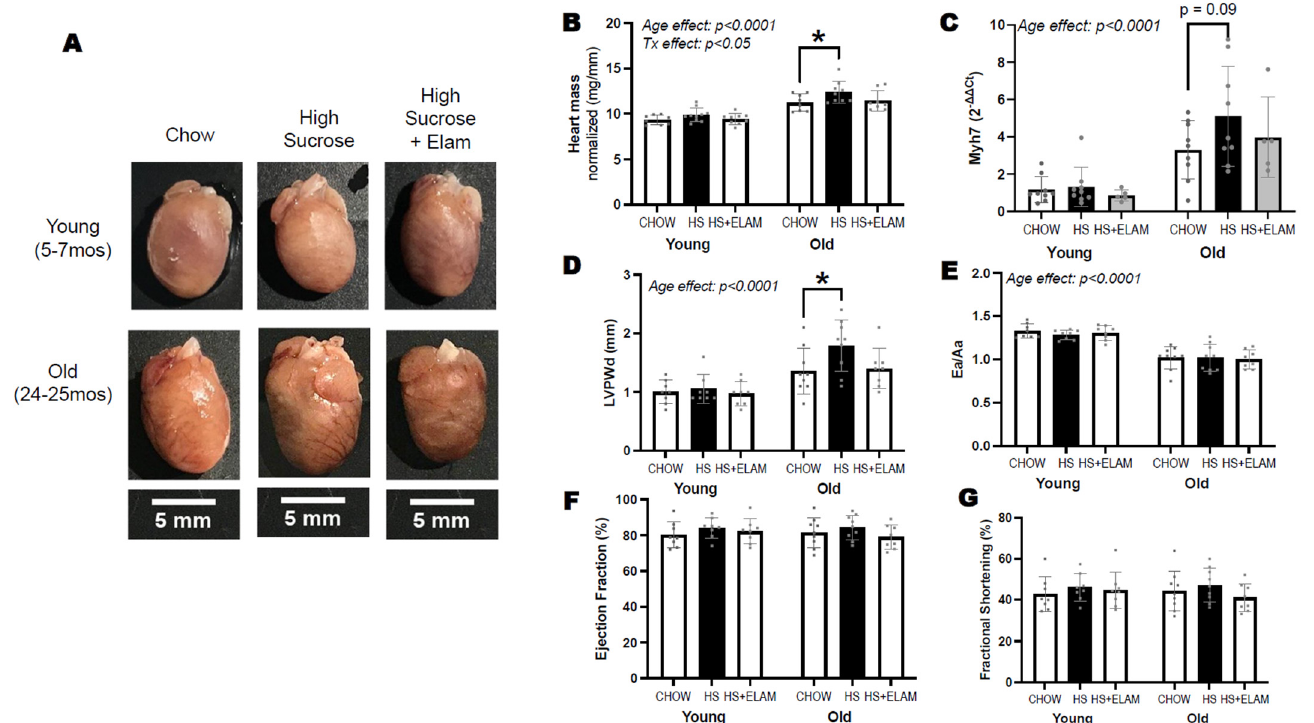
Figure 3. Representative images of dissected hearts from each group on the same scale ( A ). Heart mass normalized to tibial length ( B ). Gene expression of hypertrophy marker myosin heavy chain 7 (Myh7) is expressed relative to young–chow ( C ). In vivo measures of cardiac parameters by echocardiography include left ventricular posterior wall dimension ( D ). Ea/Aa ratio as indicator of diastolic function ( E ), and ejection fraction and fractional shortening as indicators of systolic function ( F , G ). Significant differences between old and young are indicated by age effect; differences between old–chow and old–HS are indicated with smaller brackets containing p –values if slightly above p > 0.05 or asterisks if significant, p < 0.05. Data expressed as mean ± SD.